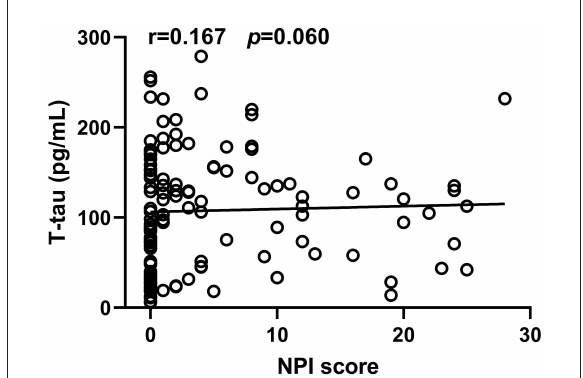
FIGURE4 The correlation between NPI score and T-tau level in CSF from PD patients was analyzed. It was observed that NPI score significantly and positively correlated with T-tau level in CSF from PD patients.